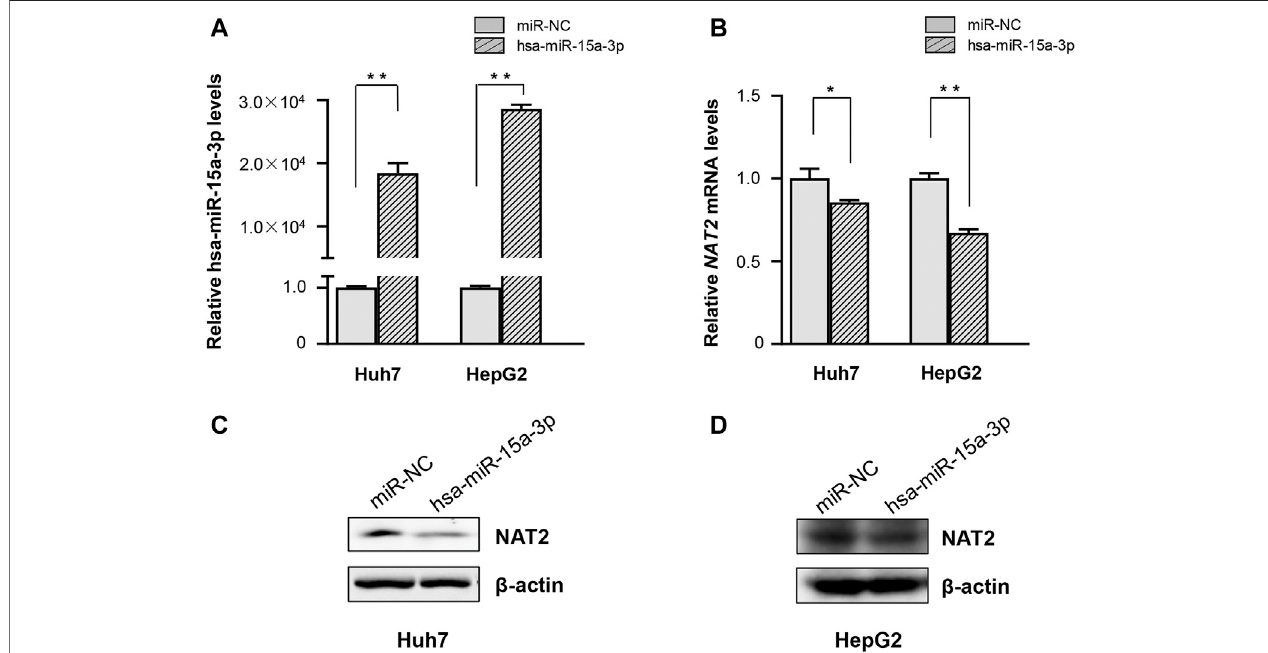
FIGURE 2 | The hsa-miR-15a-3p inhibited endogenous NAT2 expression in Huh7 and HepG2 cells. hsa-miR-15a-3p mimics or miRNA NC (both at the fi nal concentration of 20 μ mol/L) was transfected into Huh7 and HepG2 cells, respectively. (A) hsa-miR-15a-3p levels in Huh7 and HepG2 cells after transfection with hsa- miR-15a-3p mimics. (B) NAT2 expression in Huh7 and HepG2 cells after transfection with hsa-miR-15a-3p mimics. (C,D) Protein levels of NAT2 in Huh7 and HepG2 cells after transfection with exogeneous hsa-miR-15a-3p mimics. Data represented three independent experiments and were shown as mean ± SD. The fold changes of miRNA, mRNAs, and proteins when transfected with exogenous hsa-miR-15a-3p mimics were calculated based on each of their levels when transfected with miRNA negative control (miR-NC), which was de fi ned as 1. * p < 0.05; ** p <